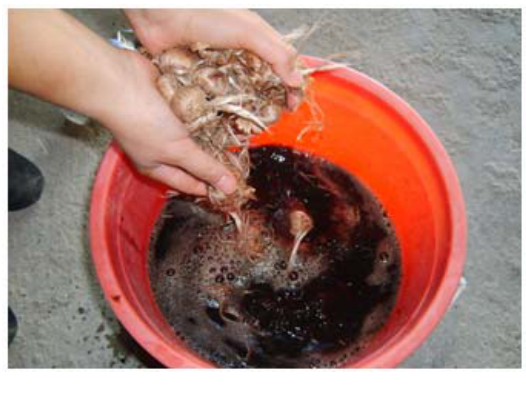
Figure 3. Biohumus treatment of saffron corms.